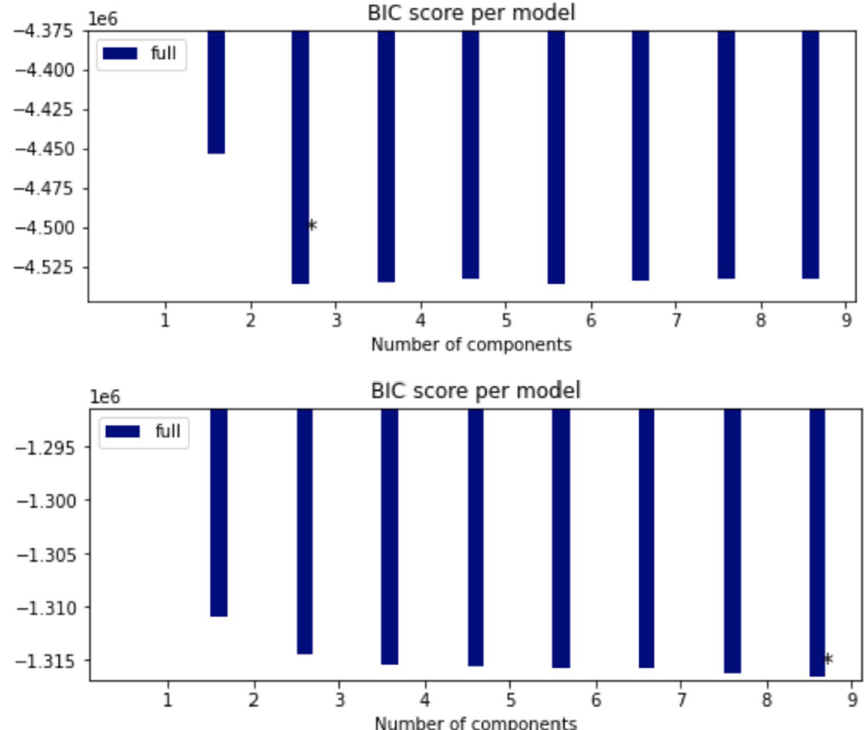
Fig. 4 States selection based on the BIC scores. Returns discretization on top and index discretization at the